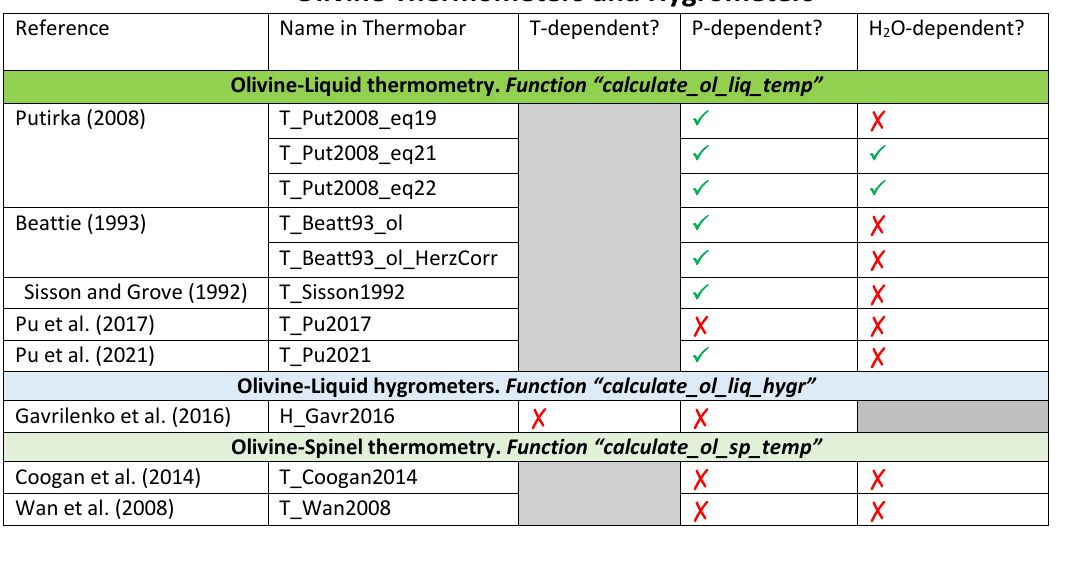
Table A3: Summary of equations for feldspar thermobarometry and hygrometry. From: Putirka 2008, Putirka 2005, Waters and Lange 2015, Masotta and Mollo